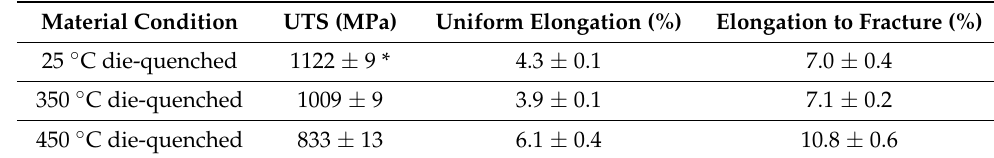
Figure 7. The measured stress-strain response in various die-quenched conditions of Ductibor ® 1000-AS; ( a ) tensile and ( b ) shear-test data. The scatter of the measured data is denoted by the error bars. Table 3. The measured tensile properties for different Ductibor ® 1000-AS die-quenched conditions.